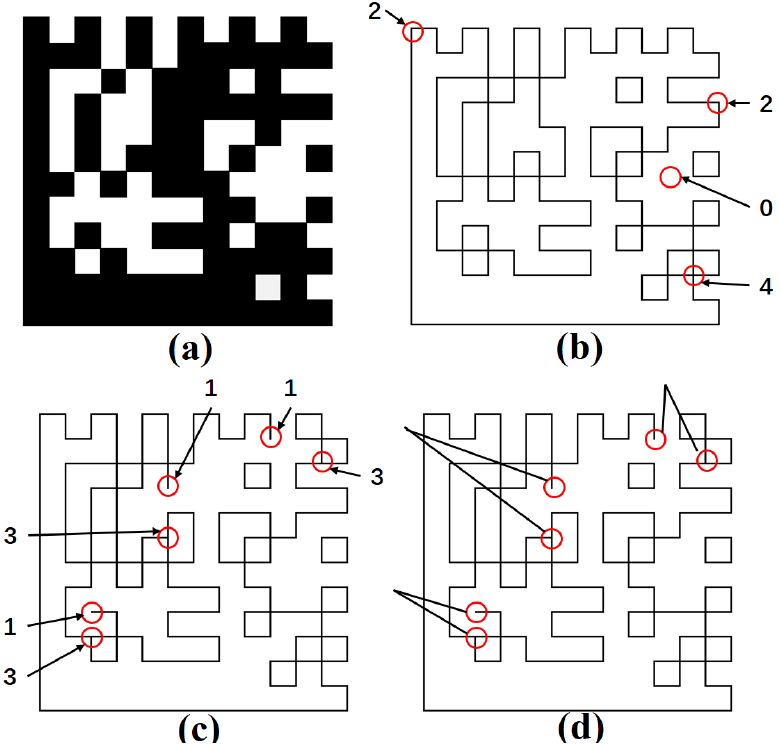
Figure 11. ( a ) A barcode image; ( b ) a standard barcode edge image; ( c ) odd-degree vertices in the edge image; ( d ) pair odd-degree vertices in the edge